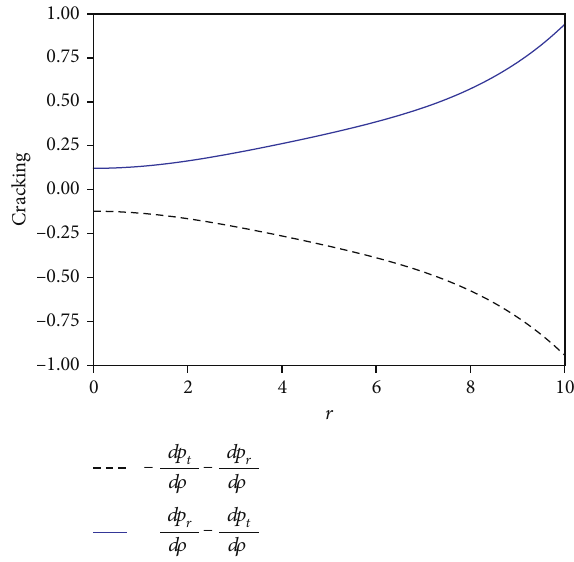
Figure 12: Herrera cracking j v 2